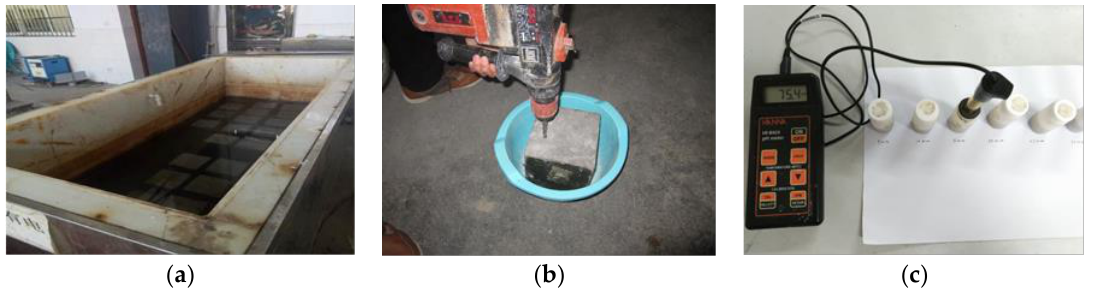
Figure 2. Chloride penetration test set-ups: ( a ) specimens immersing; ( b ) drilling holes; ( c ) RCT test.